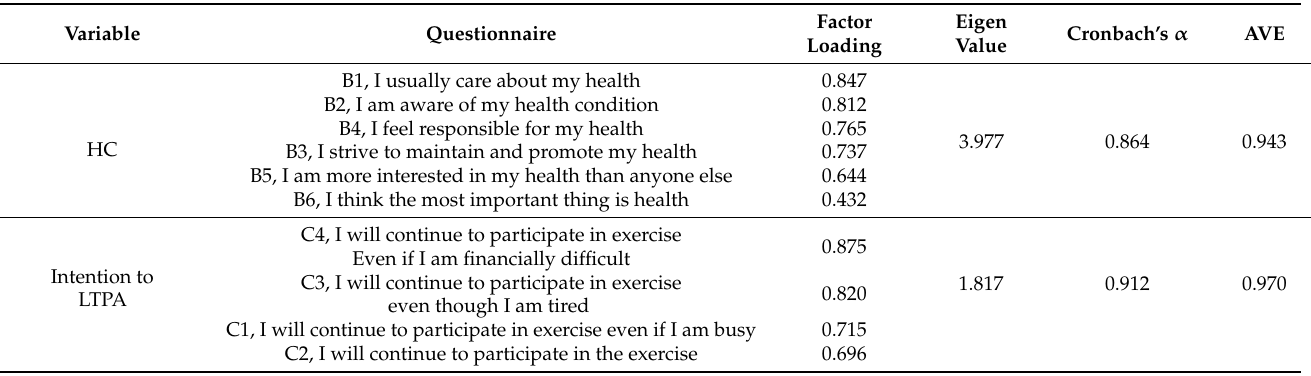
Table 2. Validity and reliability